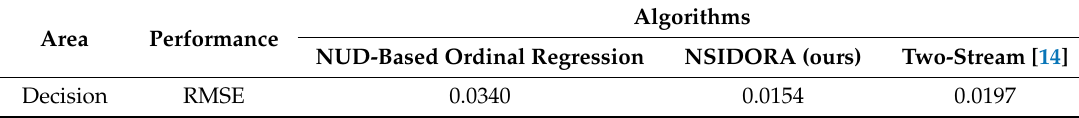
Figure 7. Root-mean-square error (RMSE) comparison of the algorithms in the decision region. Table 2. The RMSE of the four algorithms in the top 10 categories of the decision